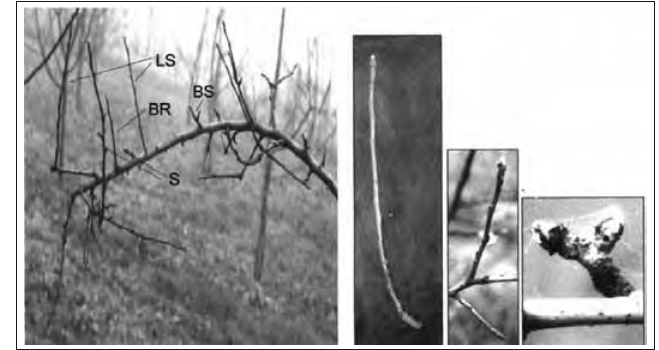
Fig. 2 - Polymorphism of the axes on an apple branch. Left : S (brachy- blast) and BS (brachyblast on a bourse) and BR (mesoblast) are preformed shoots, LS (auxiblast) are preformed and neoformed shoots. Right : Long shoot, brindles and spurs on a bourse.